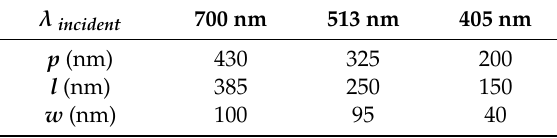
Figure 2. ( a ) The sketch of a TiO 2 nano ‐ pillar on a SiO 2 substrate. ( b – d ) The polarization conversion efficiencies of the rectangular nano ‐ pillars as a function of l and w for normal incidence of the circular polarized light at red, green, and blue, respectively. Table 1. Geometric sizes of three selected nano ‐ pillars.